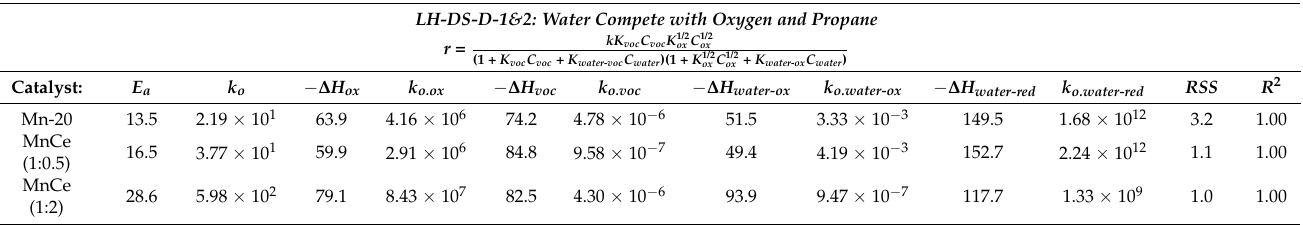
Table 7. Reaction rate expressions and kinetics parameters for applied LH model.